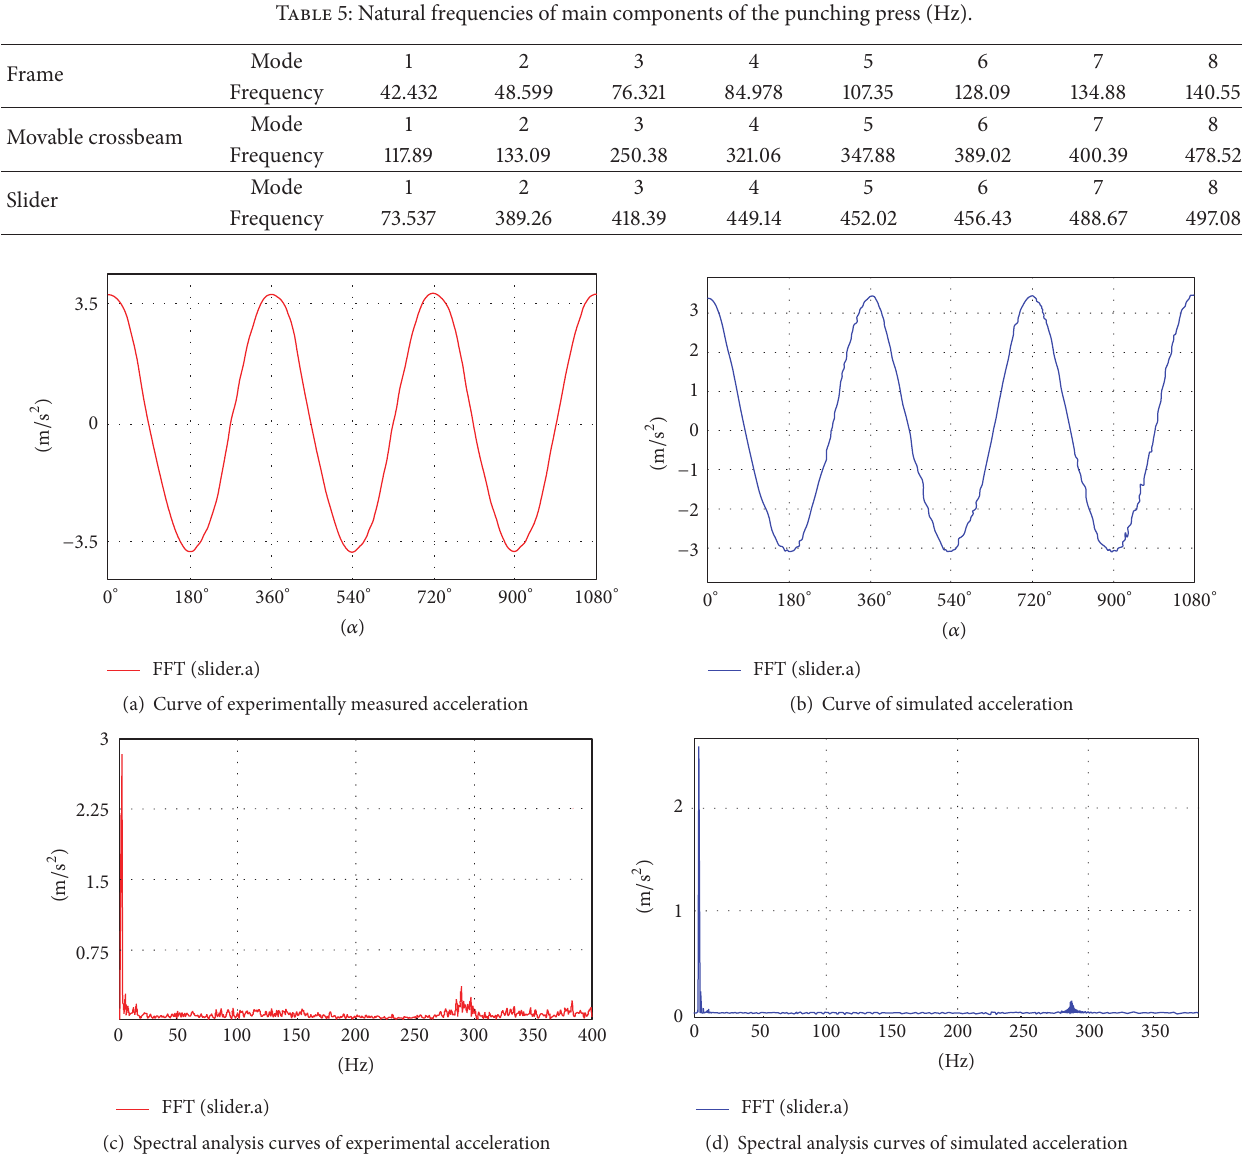
(d) Spectral analysis curves of simulated acceleration